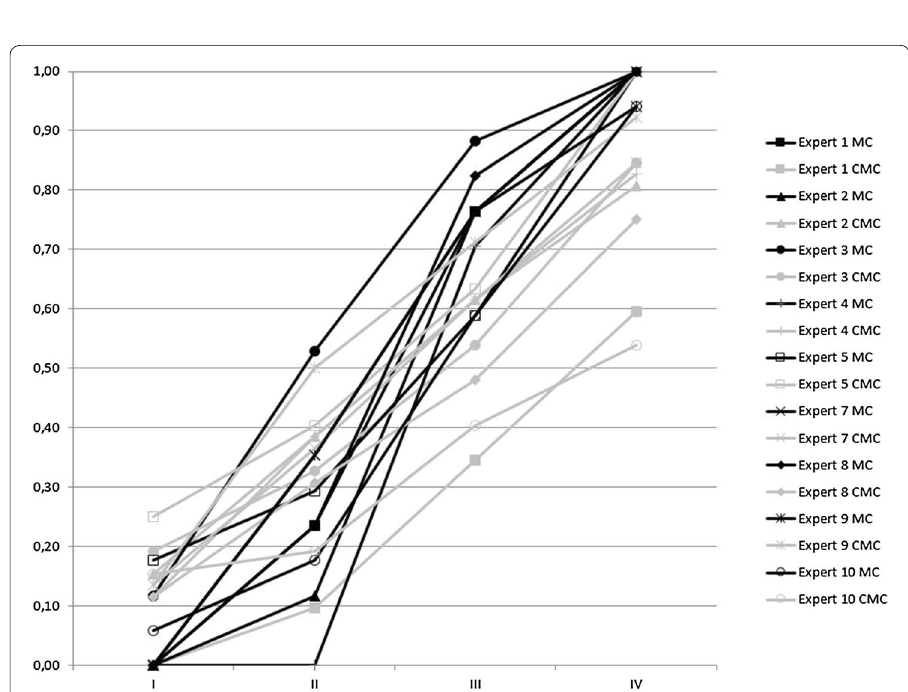
Fig. 4 Ratings of the experts for each cut score by Angoff method, round 2. Values of the same item format share the same color, values of the same expert share the same marker. Expert 6 did not show up at the workshop. MC multiple choice items, CMC scomplex multiple choice